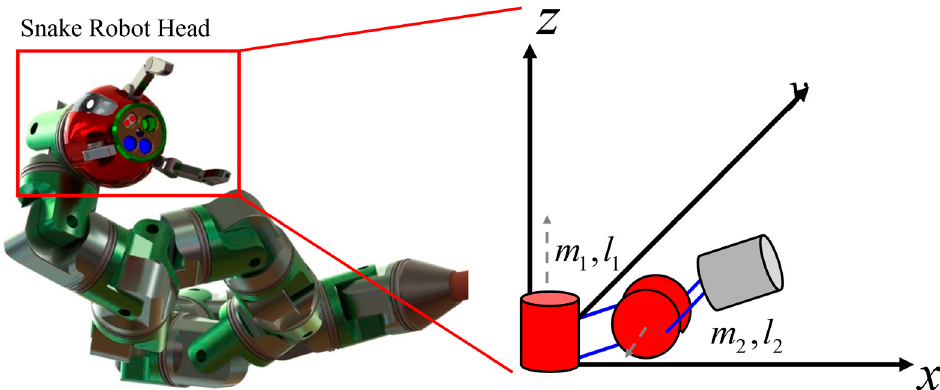
Figure 2. Snake robot’s head system con fi